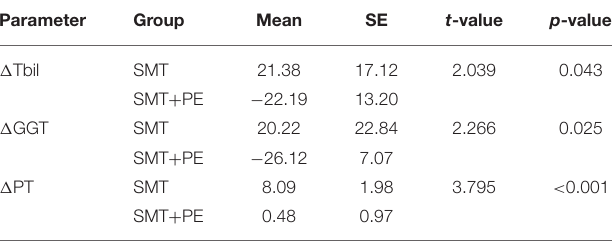
TABLE 3 | Changes in laboratory parameters in patients with HBV-ACLF who received SMT alone or combination therapy with SMT and PE-based NB-ALSS. Parameter